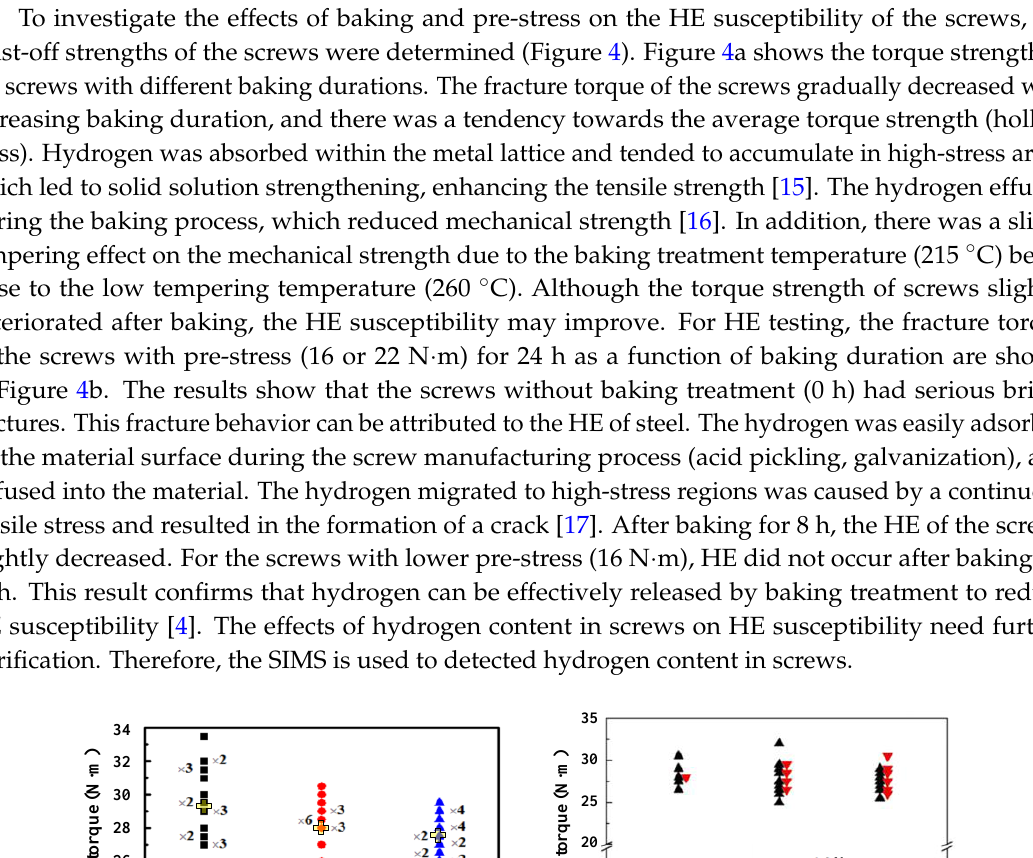
Figure 3. Microhardness profile of 10B21 screw (points at 15-mm intervals) ( a – e indicated different cross-section positions along the screw).